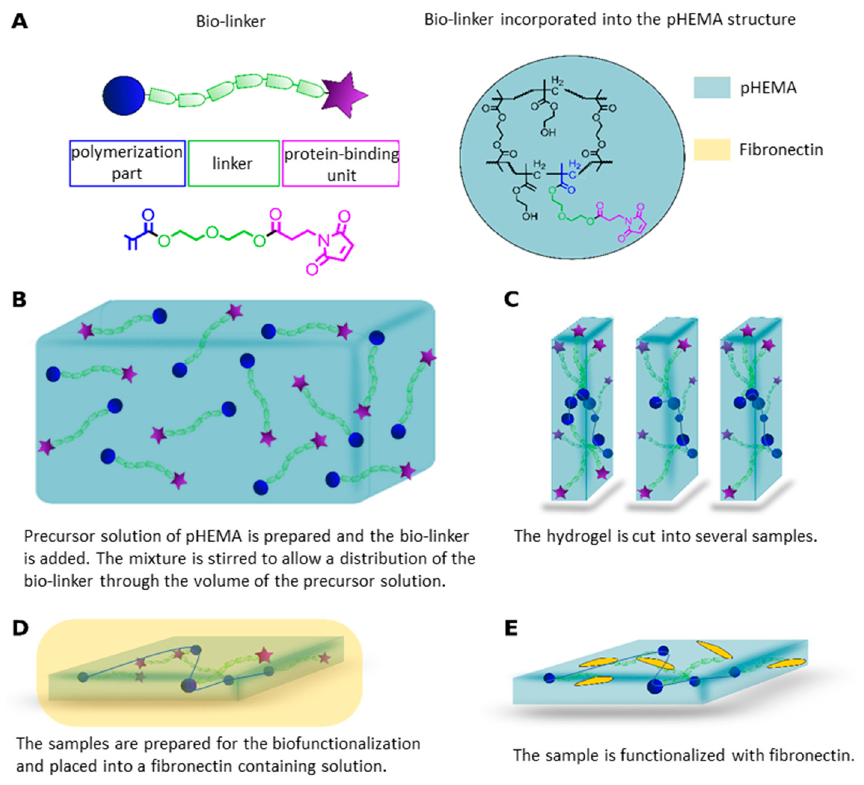
Figure 4. Schematic overview of the functionalization of pHEMA hydrogels with fibronectin. ( A ) Structure of the bio-linker ( 3 ): chemical structure of pHEMA with the incorporated bio-linker. ( B , C ) Hydrogel formation and sample preparation. ( D ) Functionalization with fibronectin (in yellow). ( E ) Fully functionalized material.